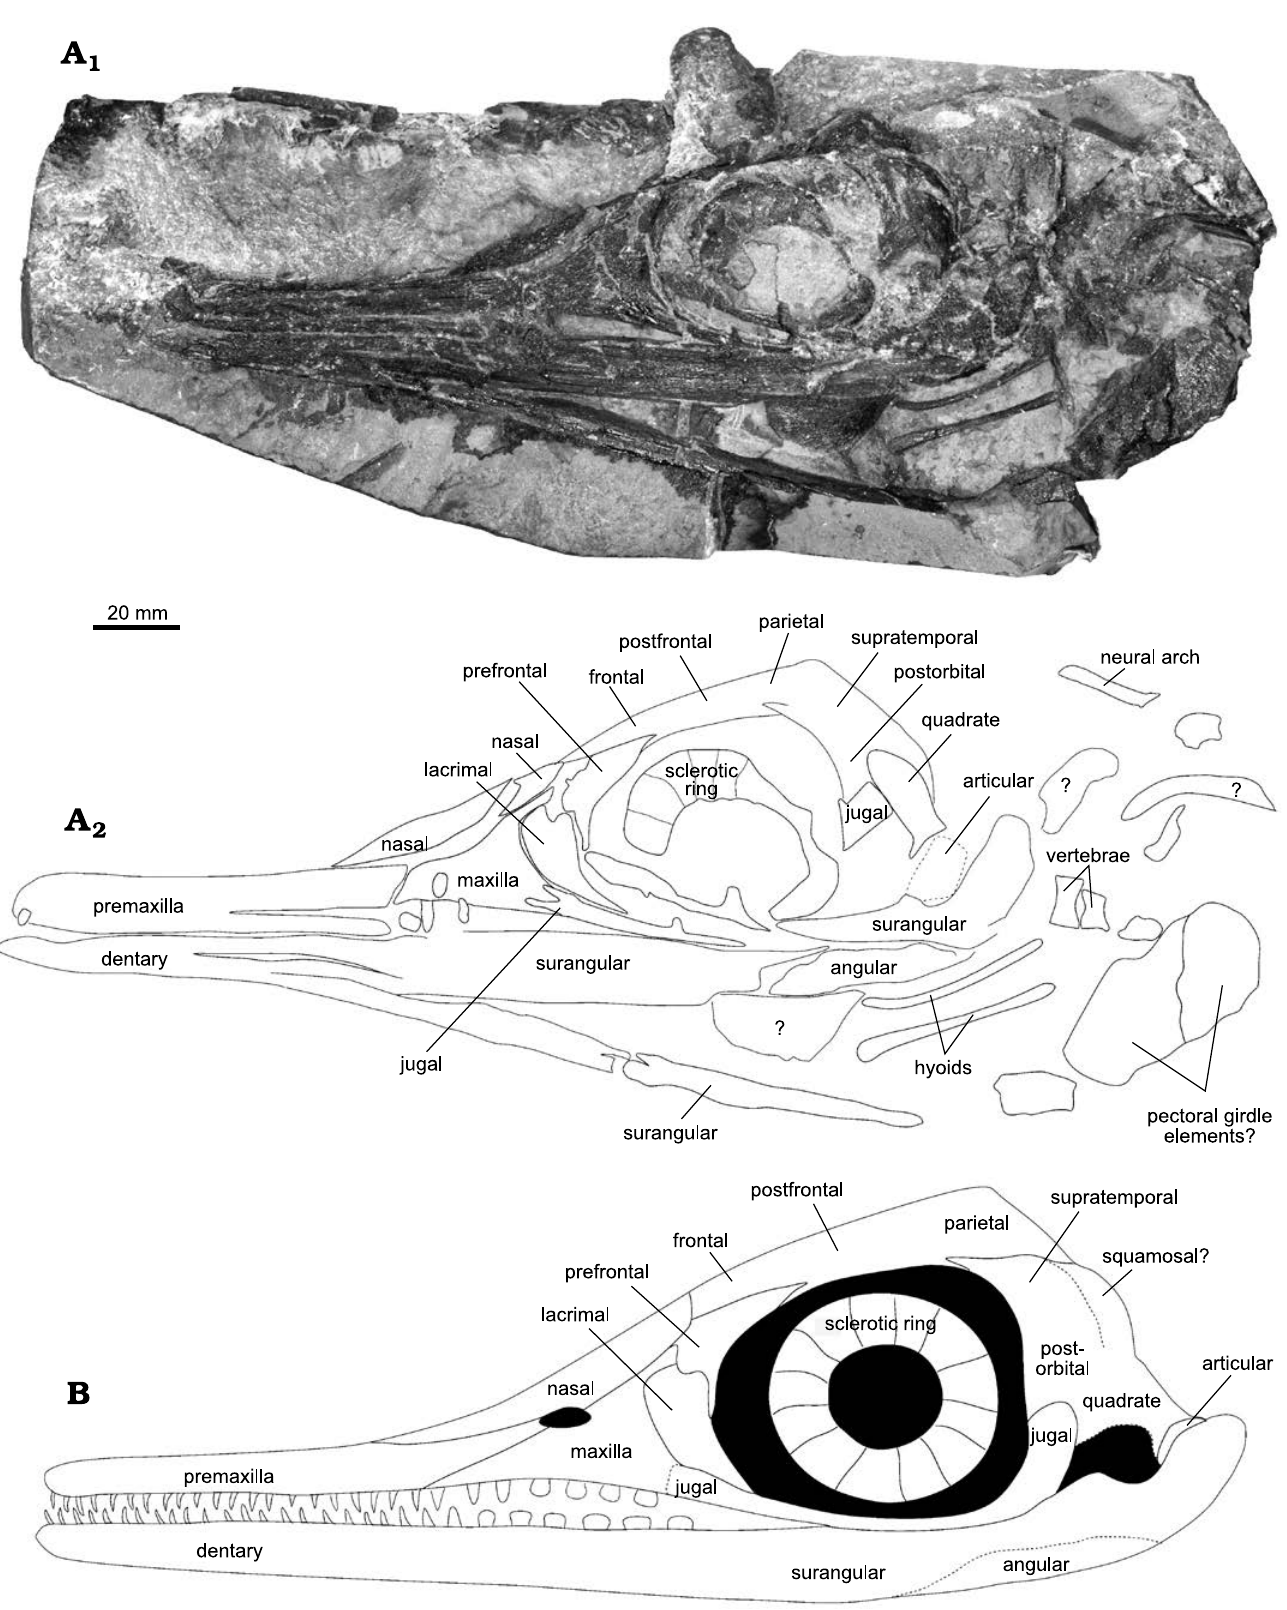
Fig. 1. Mixosaurid ichthyosaur Phalarodon fraasi (Merriam, 1910) PMO 235.393, from the Botneheia Formation, Middle Triassic of the Isfjorden area in Spitsbergen, Svalbard. A . Slab A in concretion, photograph (A 1 ), line drawing (A 2 ) showing the outline and identification of the visible bone elements. B . Hypothetical reconstruction of PMO